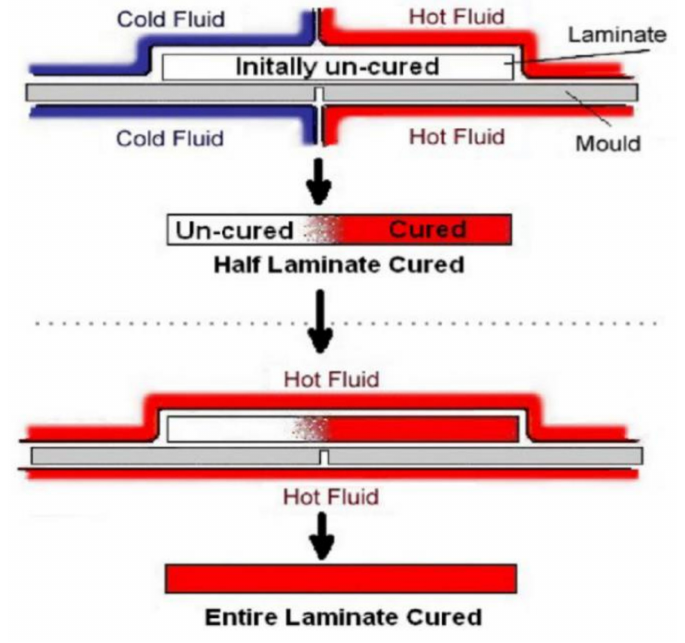
Figure 11. Schematics of the Melding Process [97]. Reprinted with permission from Elsevier.